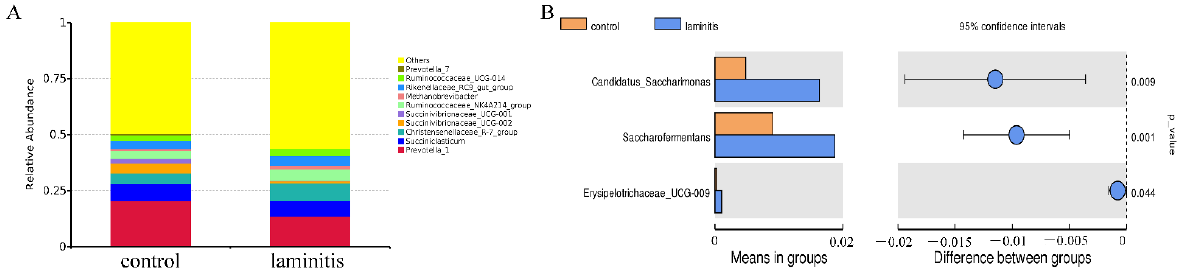
Figure 4. Changes in ruminal bacterial community at the genus level ( A ) relative abundances of the top 10 genera of rumen fluid between control and laminitis group cows. Prevotella 1 , Succiniclasticum , Succinivibrionaceae UCG-002 , Christensenellaceae R-7-group , Succinivibrionaceae UCG-001 , Ruminococcaceae NK4A214-group , Ruminococcaceae UCG-014 , and Rikenellaceae mRC9 gut group were the most abundant genera in the ruminal bacterial community; ( B ) a t -test showed that the relative abundances of Candidatus Saccharimonas , Saccharofermentans , and Erysipelotrichaceae UCG-009 were significantly increased in the laminitis group.